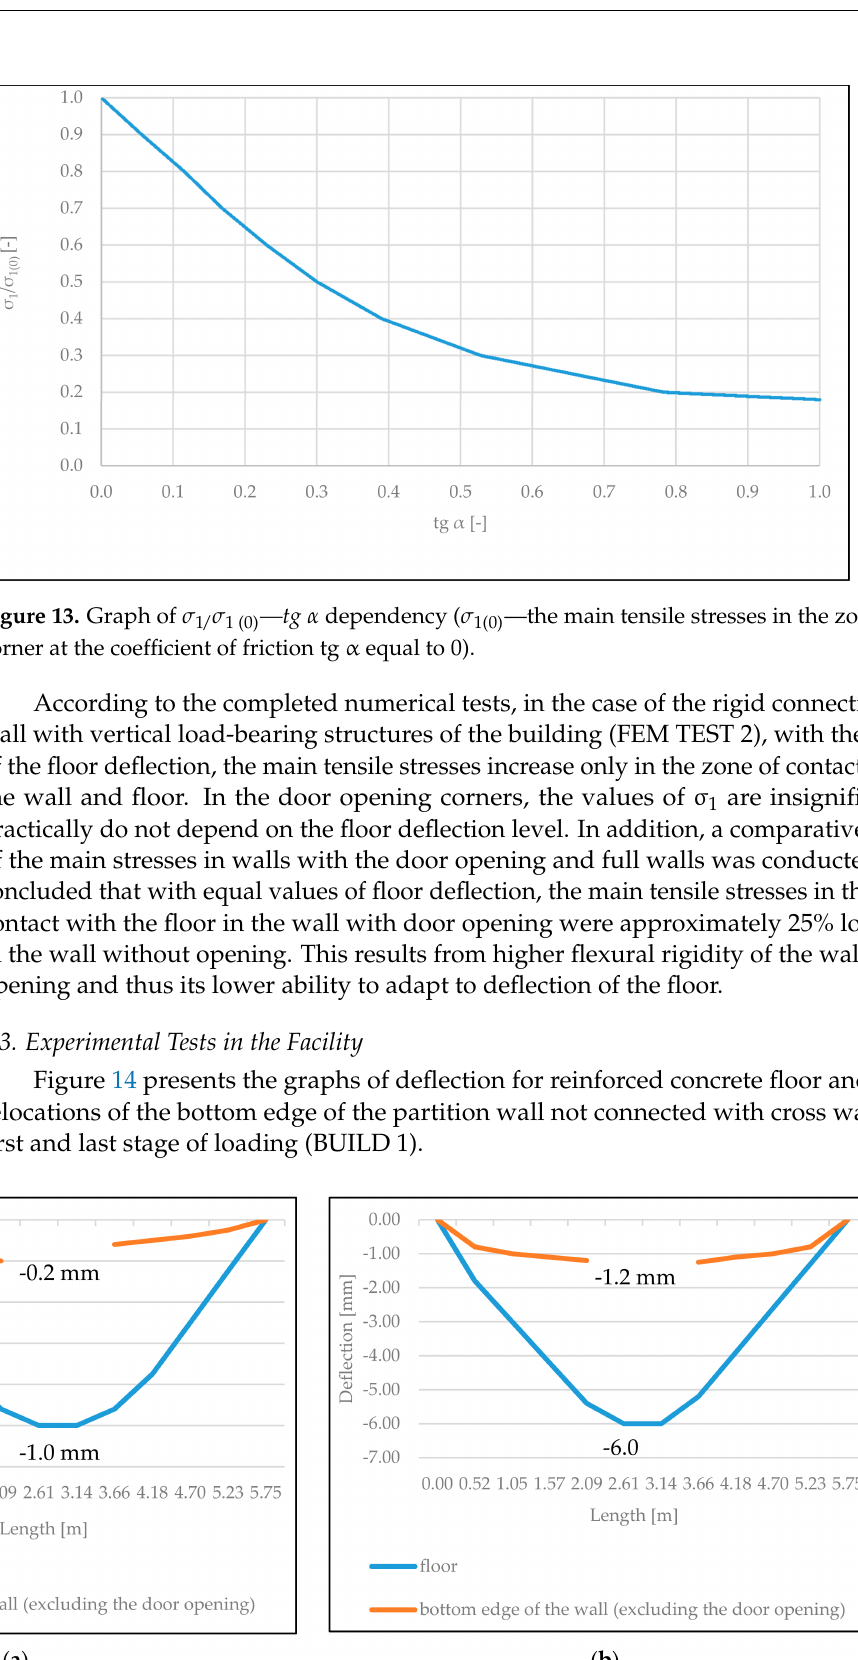
Figure 14. Graphs of deflection of the floor and bottom edge of the partition wall not connected with cross walls. ( a ) Wall at the first stage of loading and ( b ) wall at the last stage of